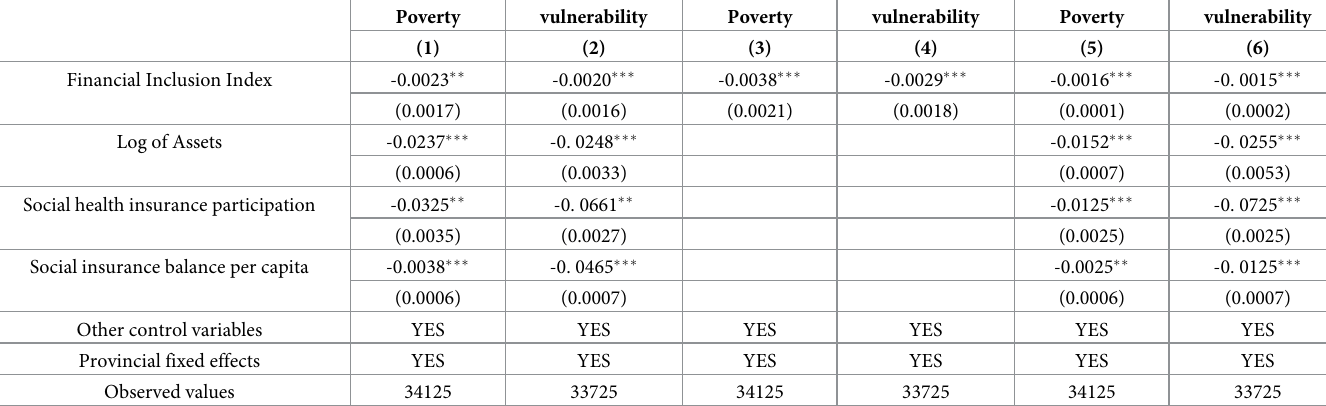
Table 4. Primary estimation results of financial inclusion on household poverty and